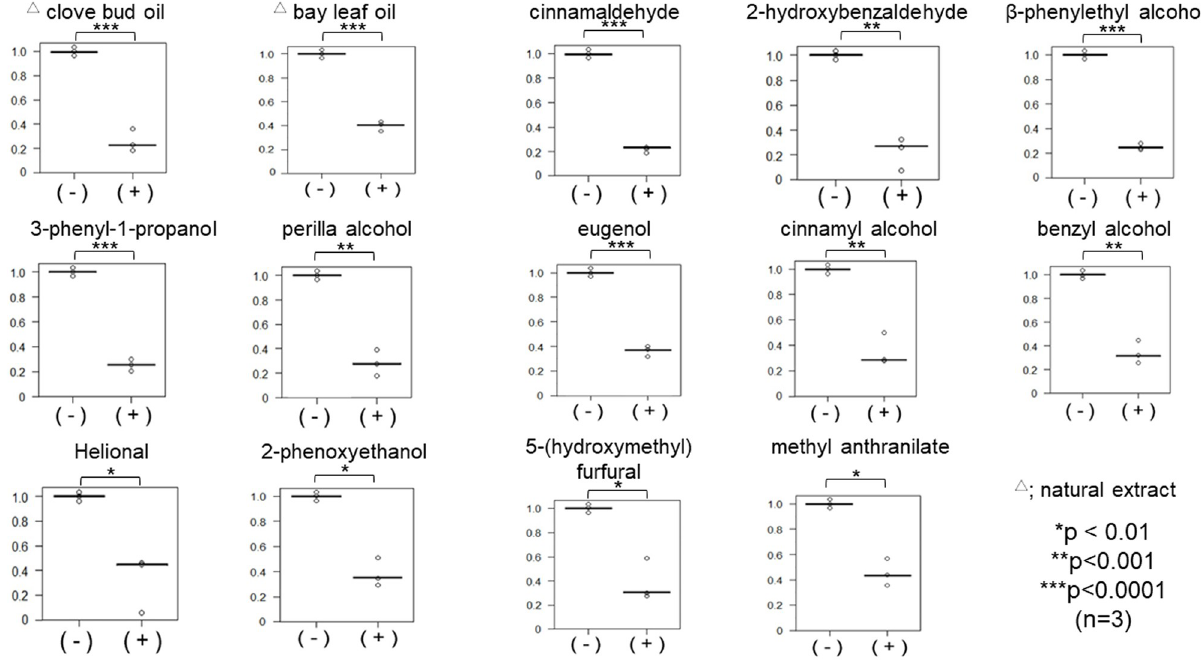
Fig 1. Inhibition of the binding of SARS-CoV-2 RBD to hACE2 by flavor/fragrance compositions. The relative binding of recombinant SARS-CoV- 2 RBD to recombinant hACE2 was evaluated in 96 well plates with or without 0.5% (v/v) flavor/fragrance compositions; 0.5% DMSO was used as the solvent for each flavor/fragrance composition and 0.5% DMSO served as the negative control (= 1.0). Three independent experiments were performed. Statistical differences between DMSO control (-) and DMSO with flavor/fragrance composition (+) were evaluated using Student’s t -test (n = 3 � p < 0.01, �� p < 0.001, ��� p < 0.0001). Triangles( 4 ) indicate natural extracts.